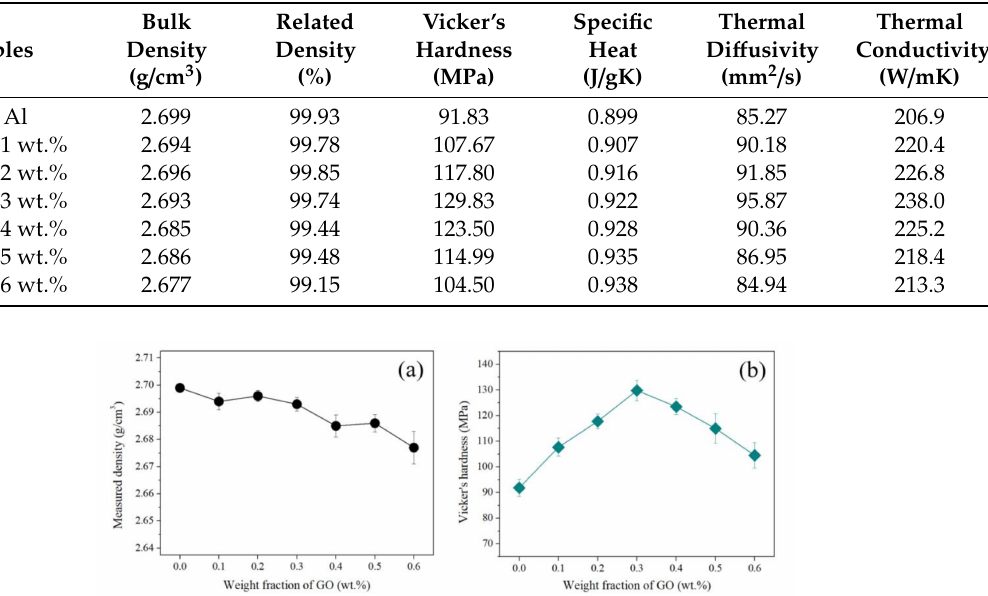
Figure 6. Mechanical properties of composites by weight fraction of GO: ( a ) density measured using Archimedes principles and ( b ) Vicker’s